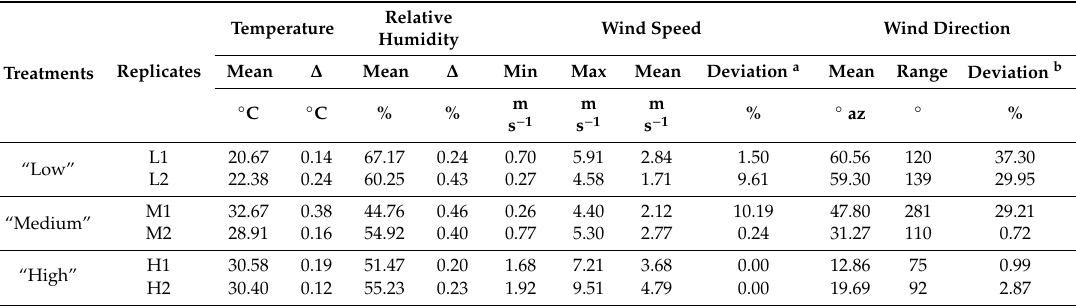
Table 2. Meteorological data collected during